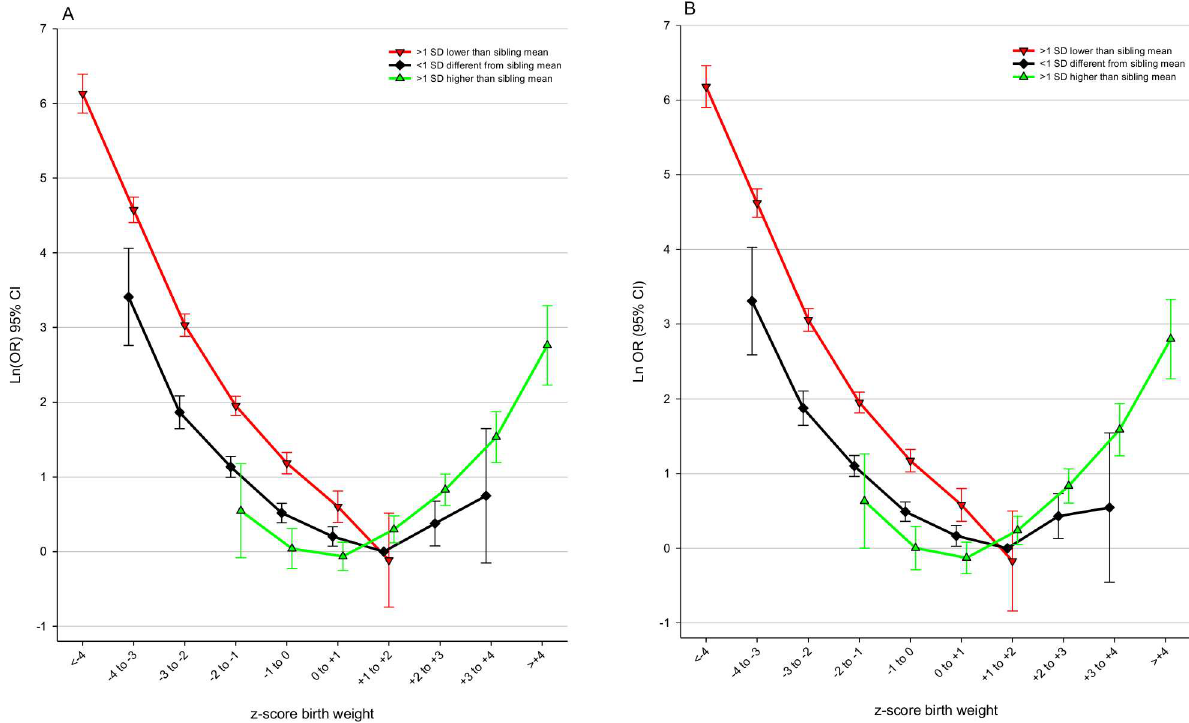
Fig 5. Associations between perinatal death and zBW, by deviance between own zBW and mean sibling zBW. CI: confidence interval; OR: odds ratio; SD: standard deviation; zBW: z-score birth weight, standardized for year of birth, sex, birth order, gestational week, and plurality. (A) Siblingsin maternal families (B) Siblingswith the same mother and father. The models includevariablesas in Model 2, with the exceptionthat a 30-category interaction term is substituted for zBW and mean sibshipzBW. Reference: participantzBW +1 to +2 and < 1SD different from mean siblingzBW. See Table 1 foot-note for